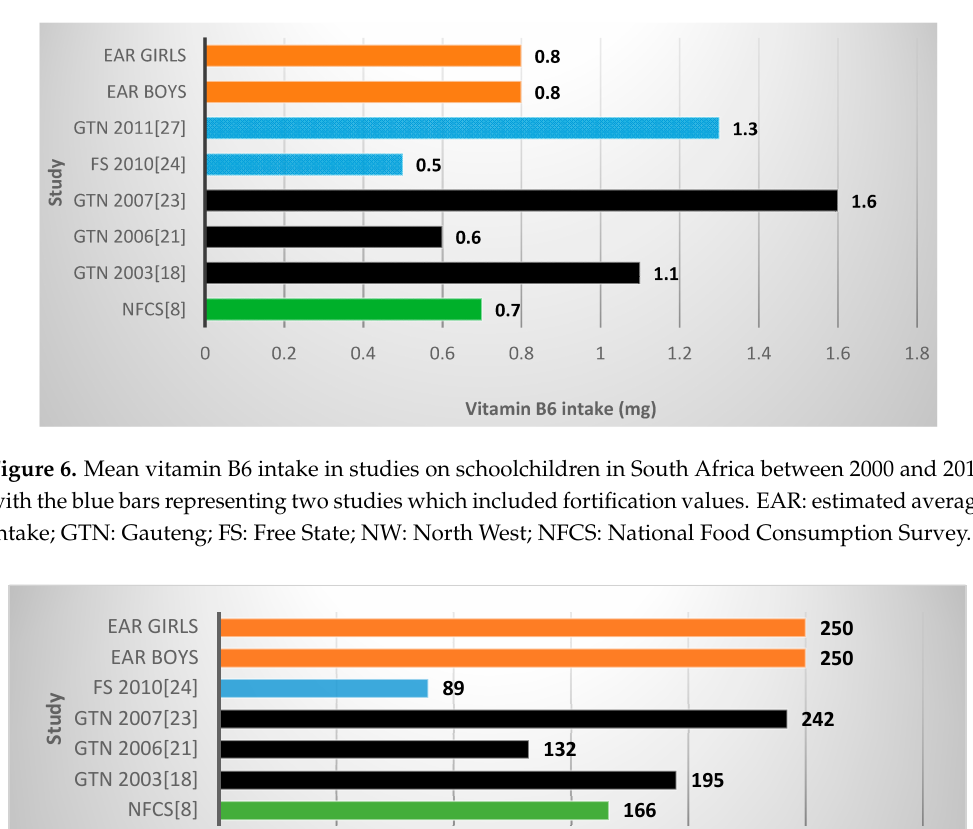
Figure 5. Mean thiamine intake in studies on schoolchildren in South Africa between 2000 and 2015 with the blue bars representing two studies which included fortification values. EAR: estimated average intake; GTN: Gauteng; FS: Free State; NW: North West; NFCS: National Food Consumption Survey.